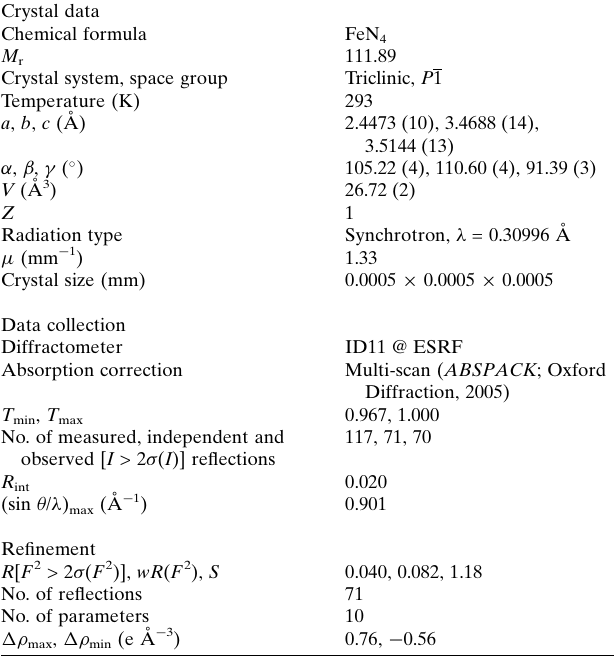
Table 3 Experimental details. Crystal data Chemical